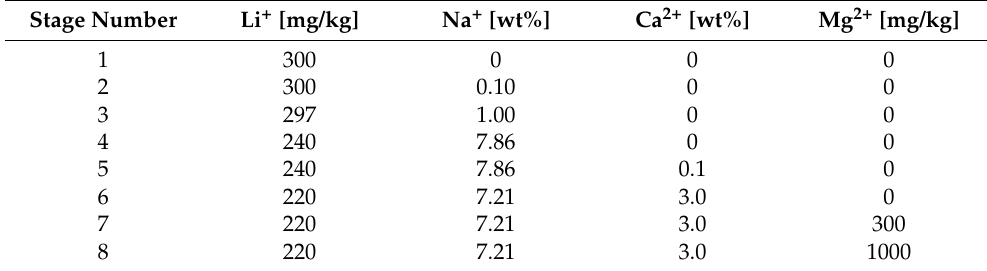
Table 1. The composition of the solution used at a given stage of screening tests. Stage Number Li +